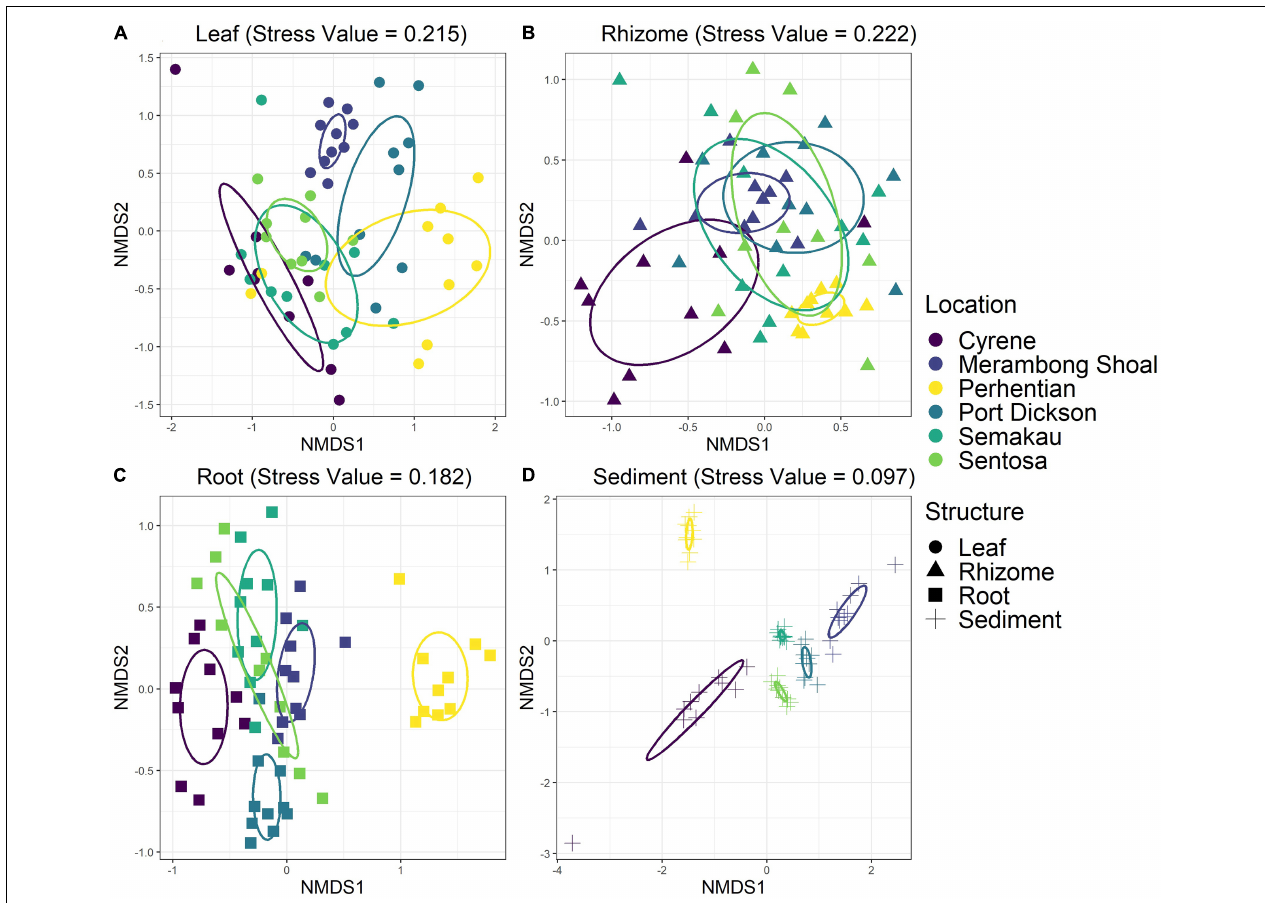
FIGURE 2 | Non-metric multidimensional scaling (NMDS) of bacterial communities based on Bray–Curtis dissimilarity, coloured by location with shapes indicating structure sampled. Plots (A–D) , show the leaf, rhizome, root, and sediment samples